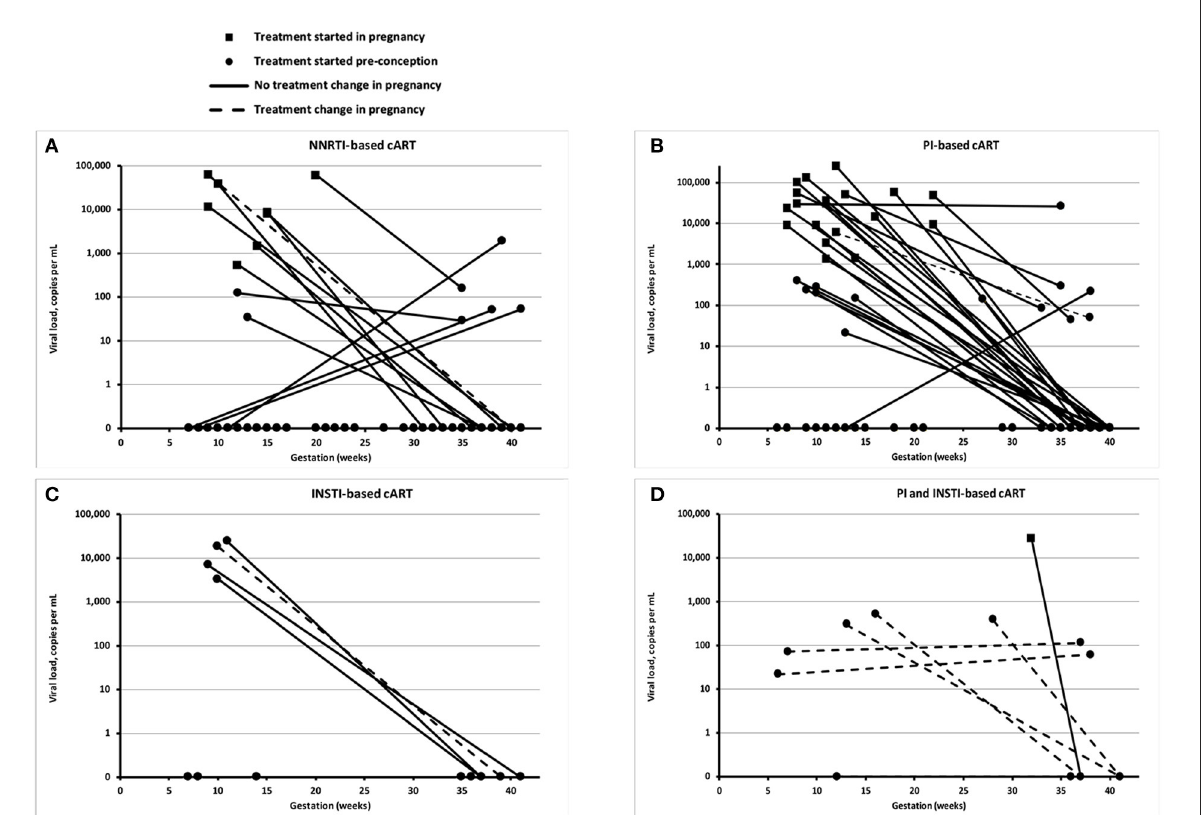
FIGURE1 Viral loads at booking and delivery. Each panel shows the viral load of individual women living with HIV (WLHIV) at booking and delivery, according to the type of combination antiretroviral therapy (cART) at delivery: NNRTI-based cART (A) , PI-based cART (B) , INSTI-based cART (C) , and PI and INST-based cART (D) . Note that some detectable viral loads at delivery are < 50 copies/mL, including one WLHIV on NNRTI-based cART and two WLHIV on PI-based